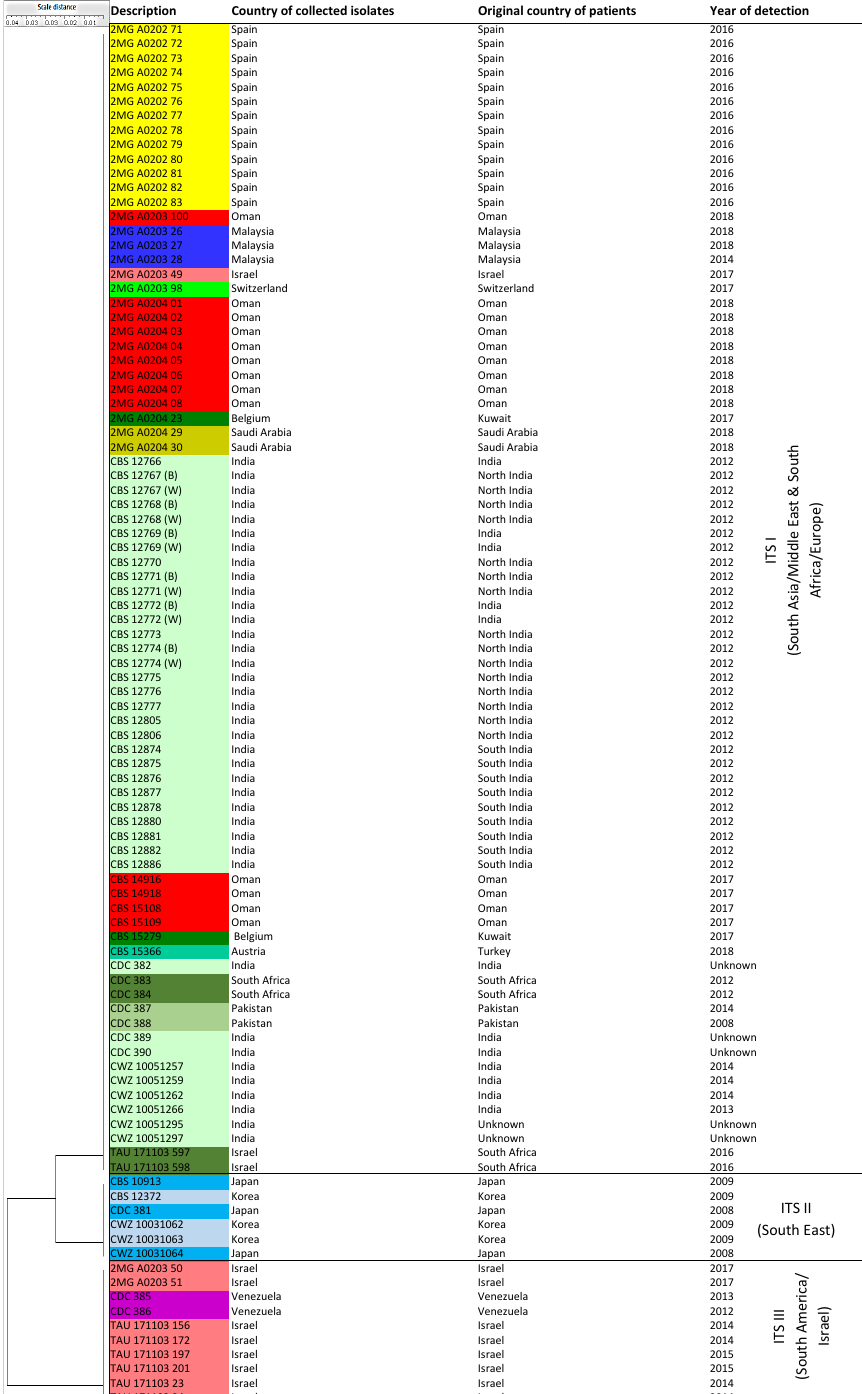
Figure 2. A UPGMA dendrogram generated with BioloMICS v12 made three clusters based on ITS sequences. ITS I included isolates from South Asia / Middle East and South Africa / Europe, ITS II and III included isolates from East Asia and South America / Israel, respectively. The color coding used for this dendrogram was the same as Figure